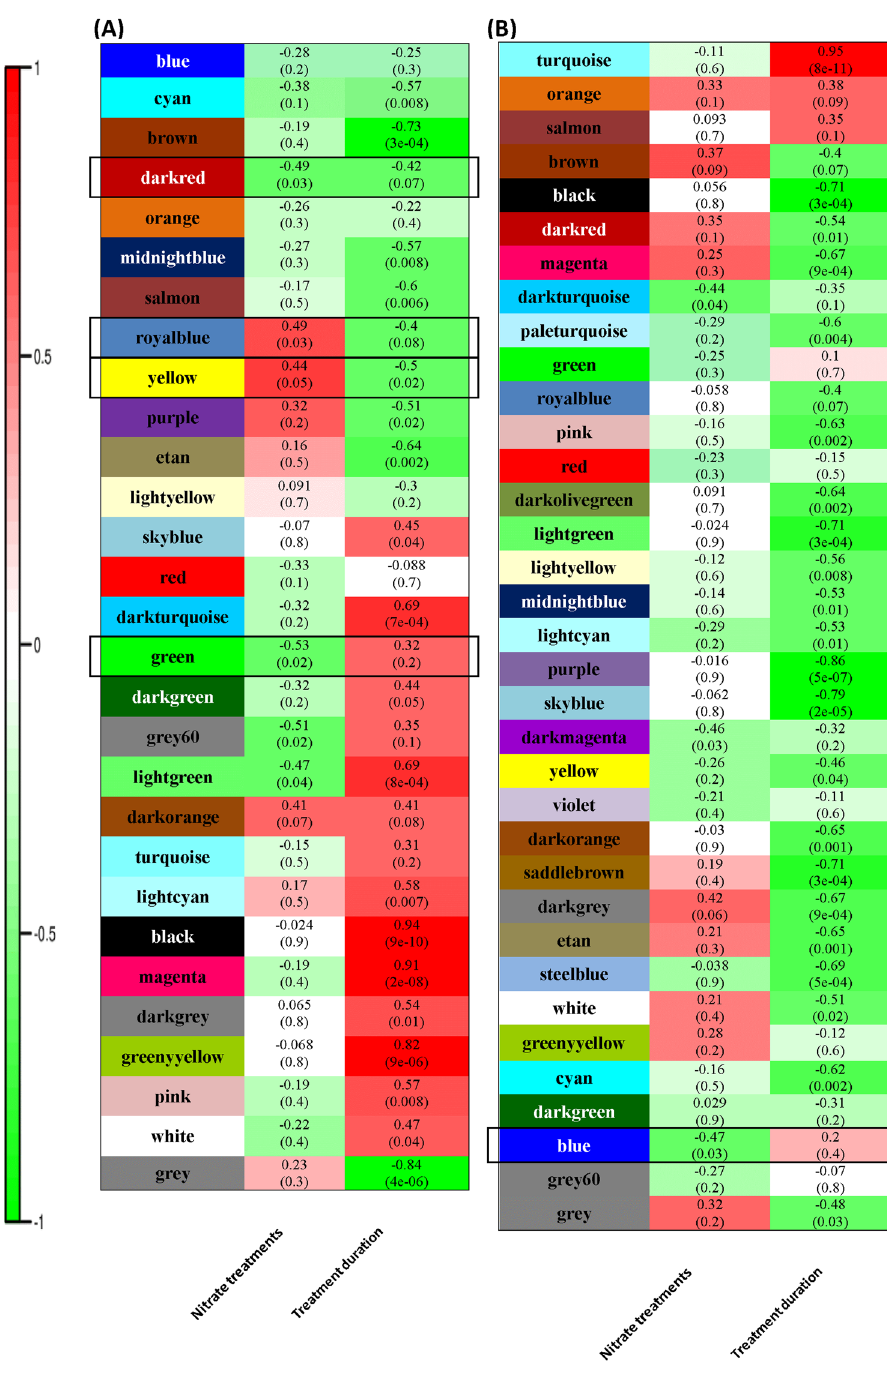
Figure 5. Enriched nitrate regulated modules in PB ( A ) and PJK ( B ). The module highlighted with black border box represents significant enriched module aassociated with nitrate response during enrichment analysis and selected for further